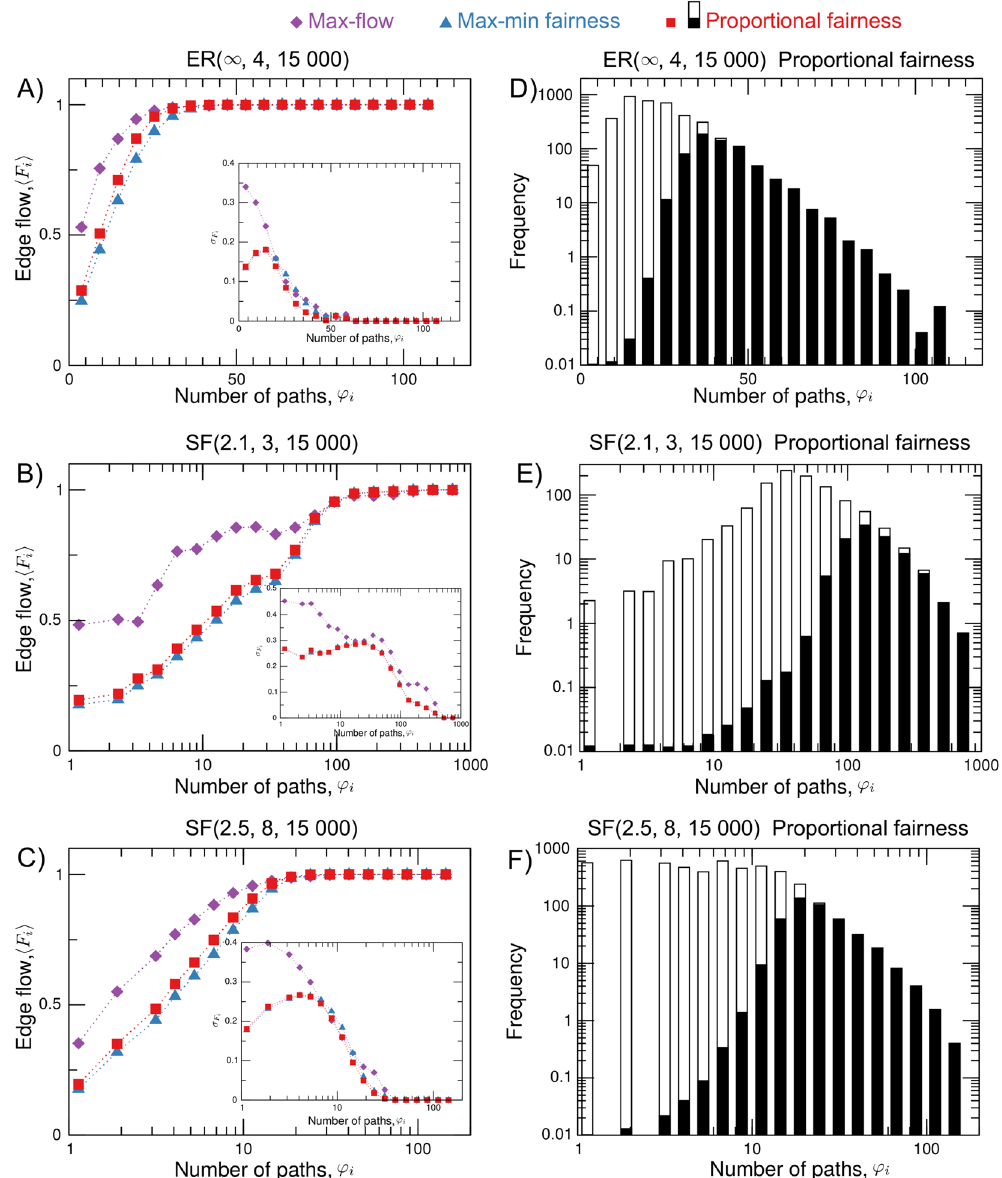
Figure 4. ( A–C ) Average edge flow vs. the number of paths ϕ i ( , )  computed from 20 random realisations with N = 2000 for Erdös-Rényi networks ER( ∞ , 4, 15 000), and for the two classes of scale-free networks on the highlighted cells in Fig. 3B–D, i.e., SF(2.1, 3, 15 000) and SF(2.5, 8, 15 000). The insets show the corresponding values of the standard deviation, illustrating that the predictability of bottleneck location improves with the increase in  ϕ i ( , ) . Panels D–F show the histograms of ϕ i ( , )  for proportional fairness, where the shaded area of each bin is the proportion of bottleneck edges in the bin (see Fig. S1 in the Supplementary Information for max-flow and max-min fairness). Bottlenecks are saturated edges, that is edges for which F i ≥ 0.999 c , where c is edge